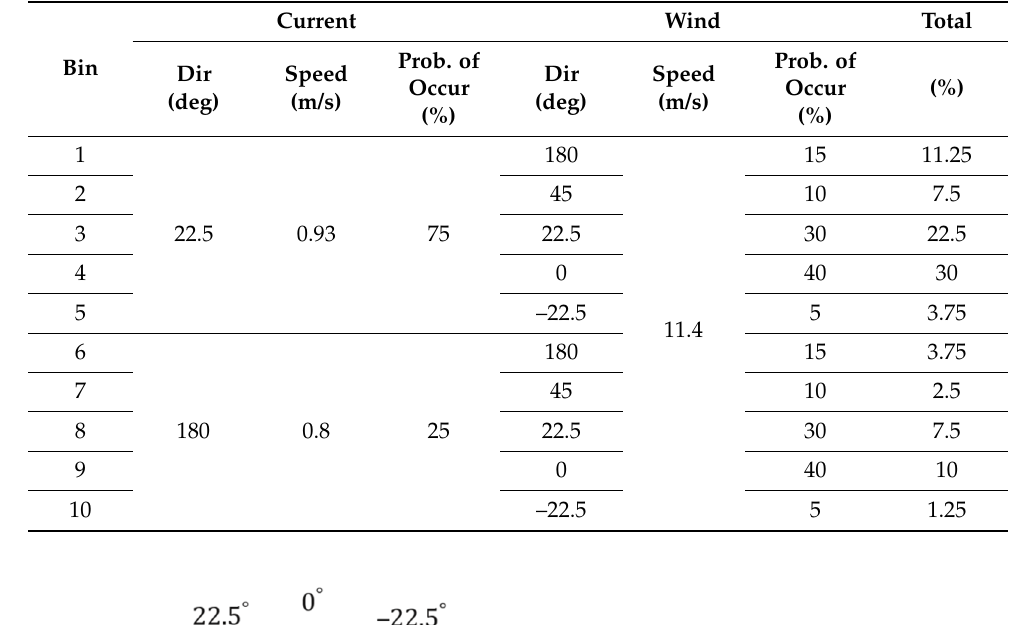
Table 5. Environmental bin according to current and wind conditions.